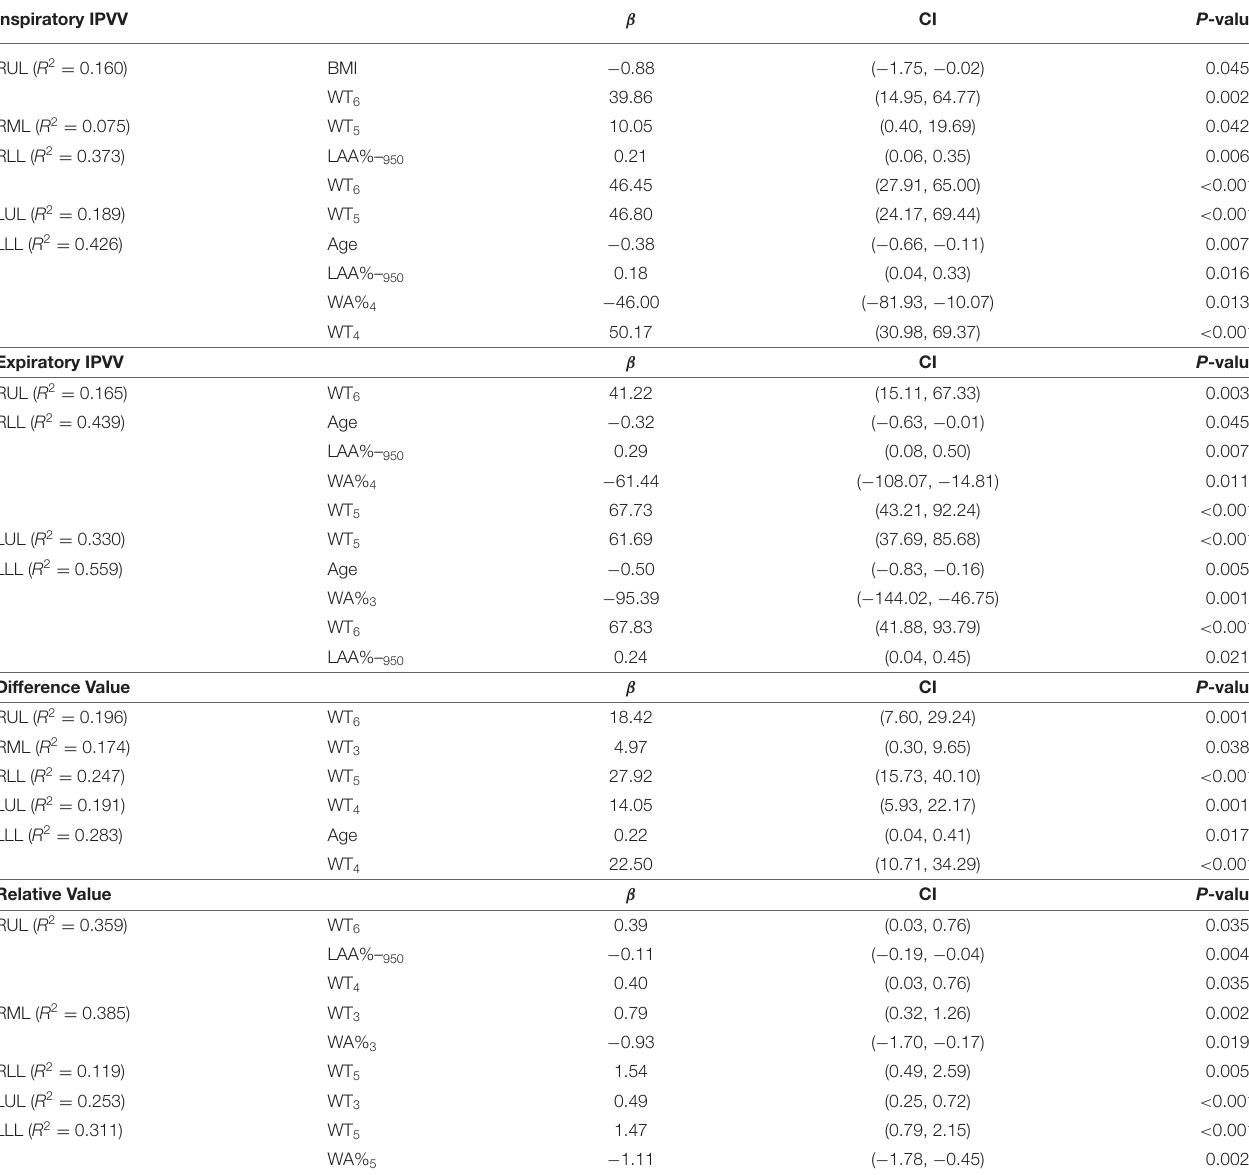
TABLE 5 | Multiple linear regression analysis of IPVV in inspiratory CT, expiratory CT, difference value and relative value. Inspiratory